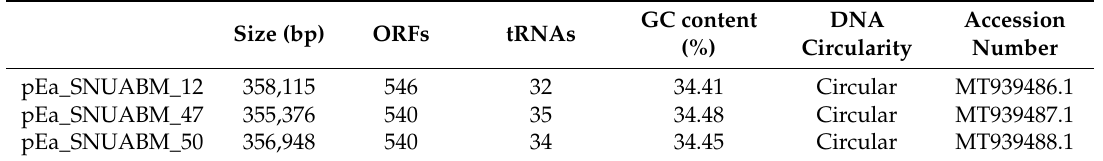
Table 2. General genomic features of Erwinia jumbo phages pEa_SNUABM_12, pEa_SNUABM_47, and